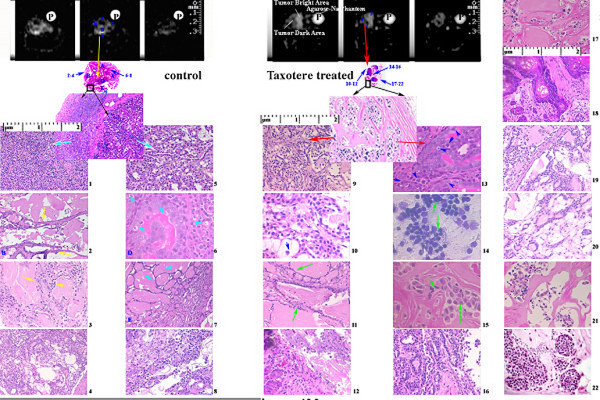
The figure represents a comparison of different tumor pre-malignant and malignant features in coregistered sodium IR images (panels in first row with phantom P) and their counterpart histology in low power (second row). Notice the heterogeneous regions of tumor and corresponding distinct histopathology. At some selected locations, relative IR sodium MR signal intensities* (A.U.) with reference to sodium phantom P (50 A.U. in top panels) are shown as numbers and histograms (see Figure 8) as distinct values for different tumor stages with different tumor features by NIH Image J 1.63. Panels (1–22) show high power optical microscopy (images 1–8) in control 0 hour (on left) and post-Taxotere 24 hours treated tumors (images 9–22 on right) with distinct features shown by arrows.